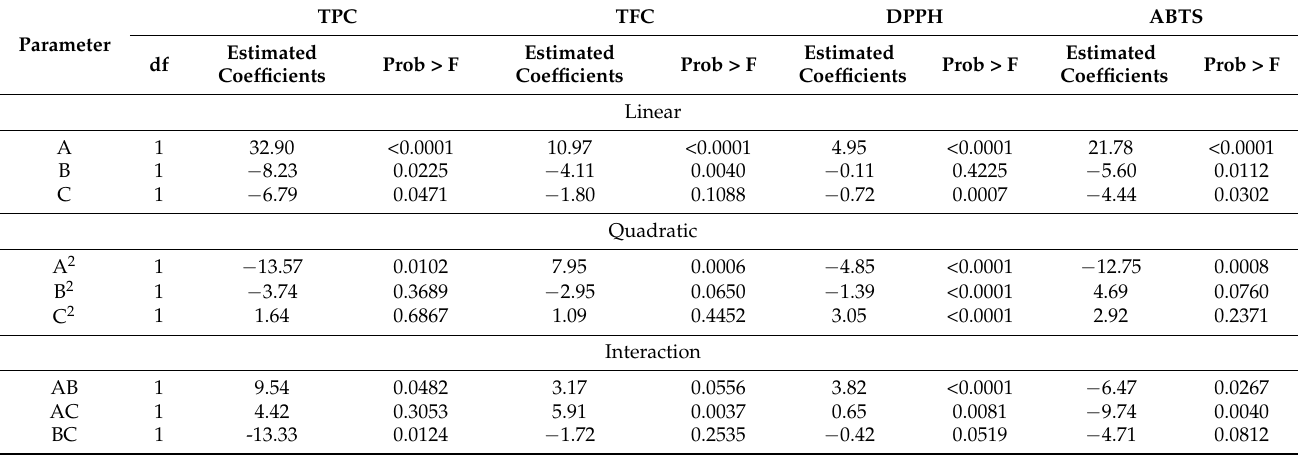
Table 2. Analysis of variance of experimental